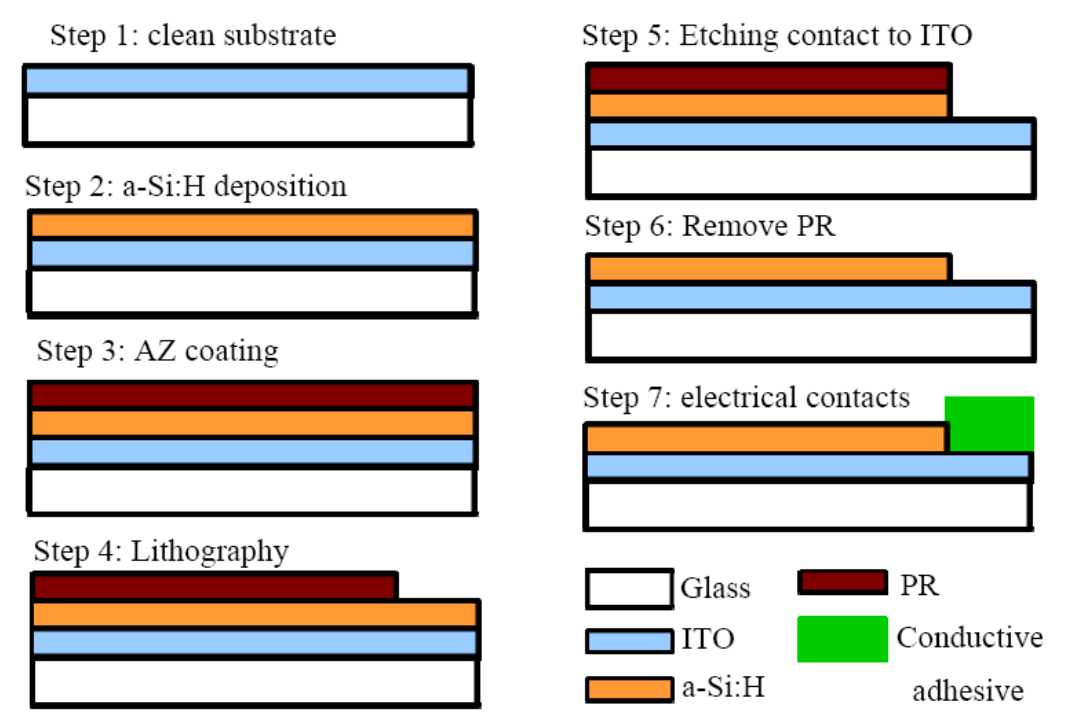
Figure 4. A possible “ODEP Chip” fabrication